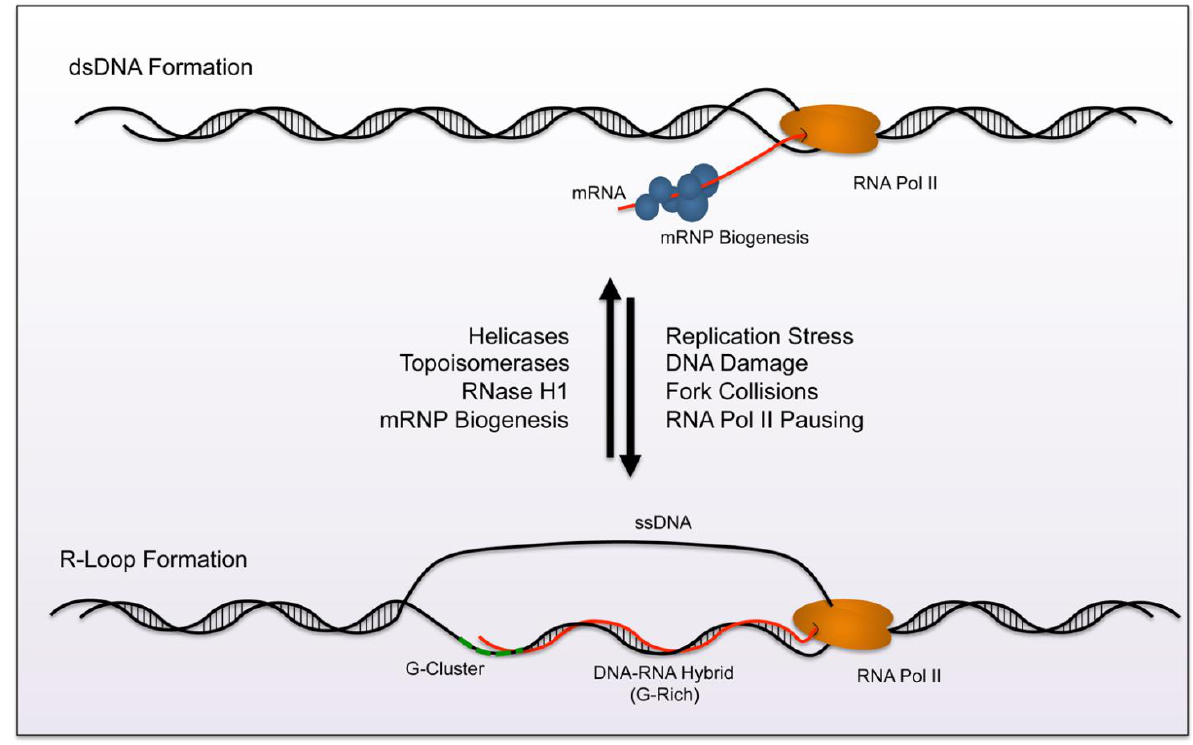
FIGURE 1: Model of R-loop homeostasis. A homeostasis exists between formation and removal of R-loops across the genome. Normally, mRNP biogenesis machinery targets nascent RNA and processes and prepares the strand for nuclear export (top). Topoisomerases and Hel- icases aid in preventing R-loop formation by reducing exposure times of ssDNA during transciption. RNase H removes R-loops by specifically digesting RNA in helical formation. Together these processes reduce R-loop accumulation during transcription. Factors that lead to pausing of RNA polymerase render conditions favorable for R-loop formation (replication stress, DNA damage, fork collisions, etc). R-loops nucleate from G-clusters (dashed green line). The loop then extends along GC rich sequences within the gene during elongation (bottom). The bal- ance between removal and formation creates an equilibrium at nucleation sites across the